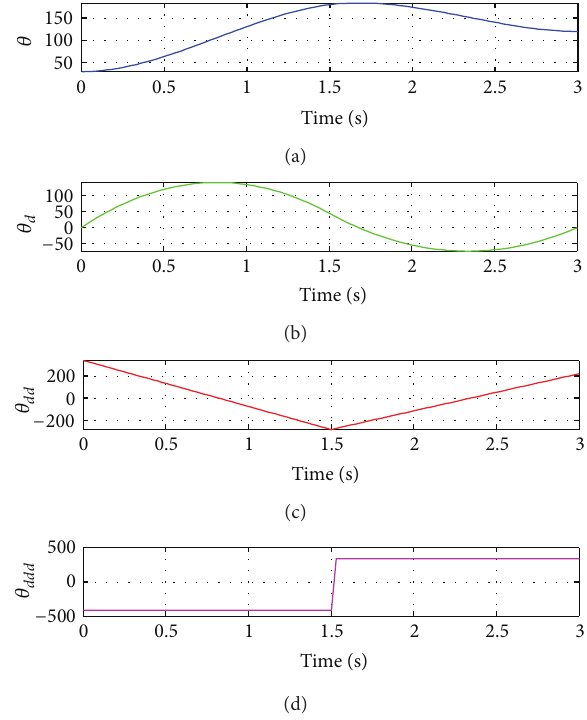
Figure 1: Two third-order polynomials with via